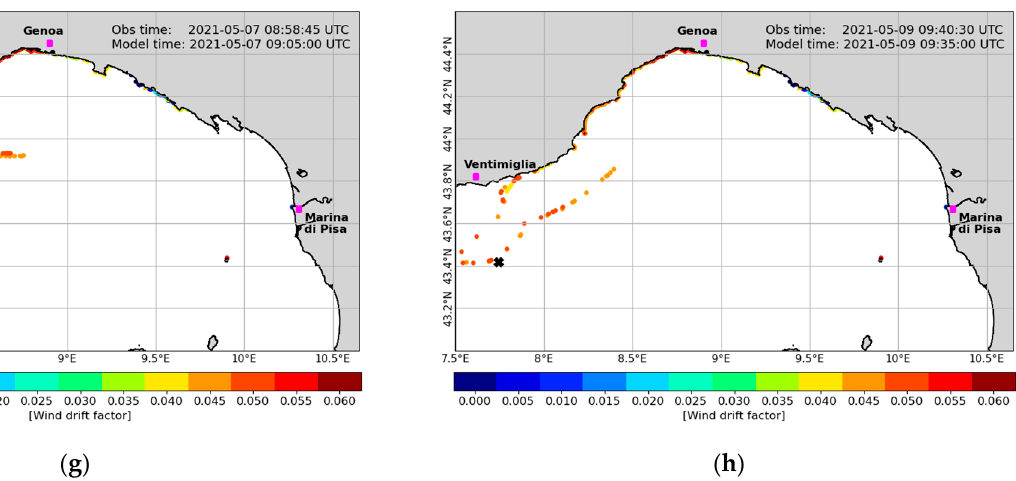
Figure 9. Modeled particles (colored dots), with colors representing different values of wind drift factor (WDF) parameter, compared to the observed position of the tablet-shaped drifter (black cross). Approximate elapsed time after the drifter’s deployment are: 3 hours panel ( a ), 12 hours panel ( b ), 6 days panel ( c ), 12 days panel ( d ), 15 days panel ( e ), 19 days panel ( f ), 22 days panel ( g ) and 24 days panel ( h ).